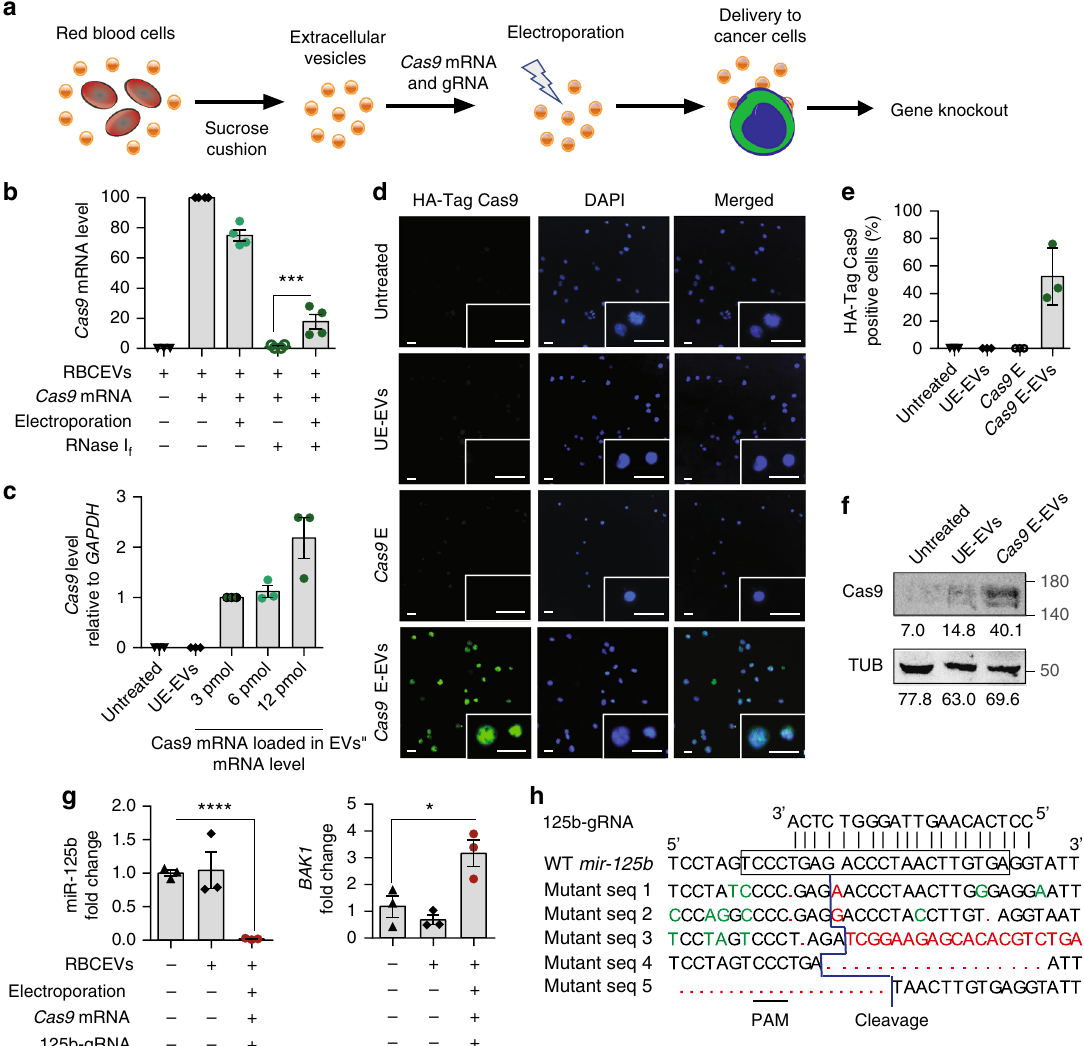
Fig. 8 RBCEVs deliver Cas9 mRNA and gRNA to leukemia cells for genome editing. a Schema of Cas9 mRNA and gRNA delivery. b Average level of Cas9 mRNA in 6.2 × 10 11 RBCEVs untreated, incubated or electroporated with 6 pmol Cas9 mRNA and treated with RNase I f , relative to the unelectroporated Cas9 level (2nd condition). c The level of Cas9 mRNA relative to GAPDH mRNA in MOLM13 cells that were incubated with 12.4 × 10 11 unelectroporated RBCEVs (UE-EVs) or RBCEVs electroporated with 3, 6, or 12 pmol Cas9 mRNA (E-EVs) after 24 h of treatment, relative to the 3 pmol condition. d Representative images of MOLM13 cells that were incubated for 48 h with 12.4 × 10 11 UE-EVs or EVs that were electroporated with 6 pmol Cas9 mRNAs. MOLM13 cells were also electroporated directly with 6 pmol Cas9 mRNAs ( Cas9 E) for comparison. The cells were stained for HA-Cas9 protein (green) and nuclear DNA (Hoechst, blue). Scale bar, 20 μ m. e Average percentage of MOLM13 cells stained positive for HA-Cas9 protein as shown in d . f Western blot analysis of Cas9 and α -tubulin (TUB) in MOLM13 cells untreated, treated with 12.4 × 10 11 unelectroporated or 6 pmol- Cas9 mRNA-loaded RBCEVs. Below each band is its mean intensity, quanti fi ed using ImageJ. g miR-125b and BAK1 expression fold change, relative to untreated condition, normalized to U6b RNA and 18s RNA respectively, in MOLM13 cells treated with 12.4 × 10 11 UE-EVs or EVs loaded with 6 pmol Cas9 mRNA and mir-125b -targeting gRNA for 48 h. h Alignment of mir-125b -targeting gRNA with wildtype (WT) mir-125b (frame indicates mature sequence) and mutant DNA sequences from MOLM13 cells treated as in g . Red, insertion or deletion. Green, mismatch. PAM protospacer adjacent motif. All the bar graphs are presented as mean ± SEM ( n = 3 or 4 repeats of 3 or 4 cell passages). * P < 0.05; *** P < 0.001; **** P < 0.0001: one-tail Student ’ s t